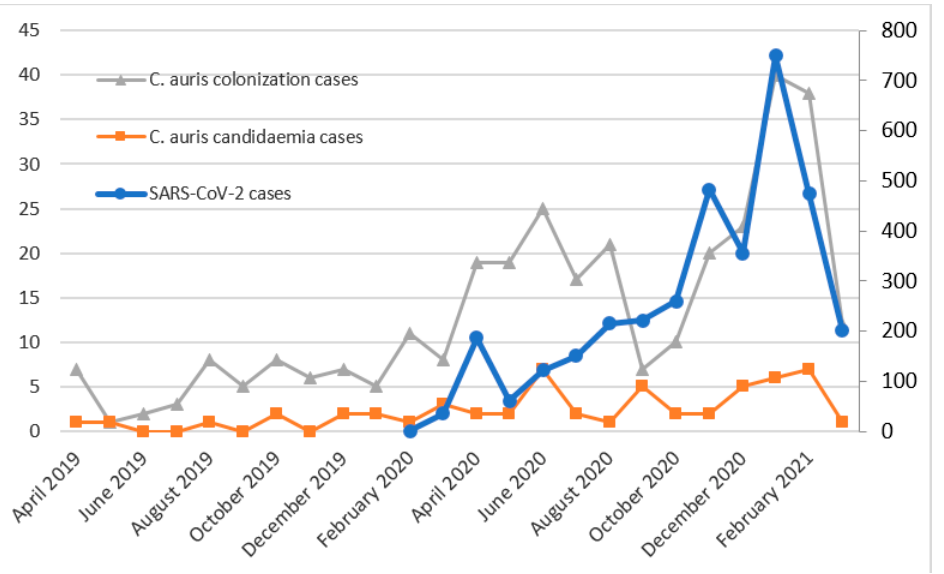
Figure 2. Temporal evolution of C. auris colonization and candidaemia cases (left axis) and SARS-CoV-2 cases (right